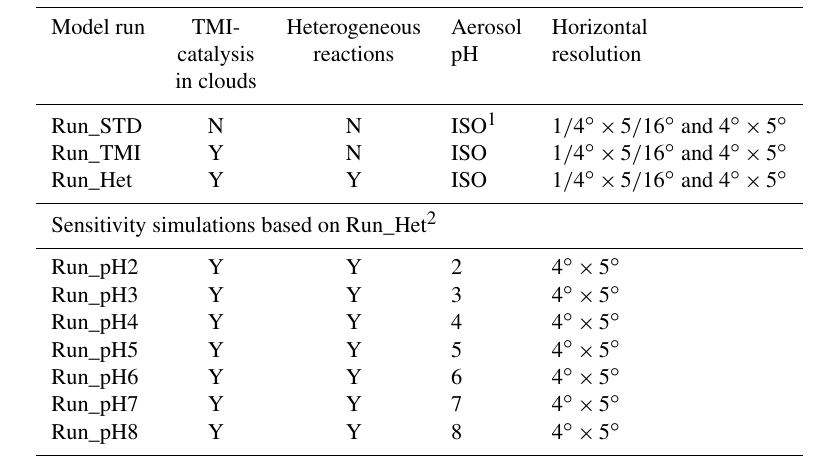
Table 1. Description of model simulations. Model run TMI- Heterogeneous Aerosol Horizontal catalysis reactions pH resolution in clouds